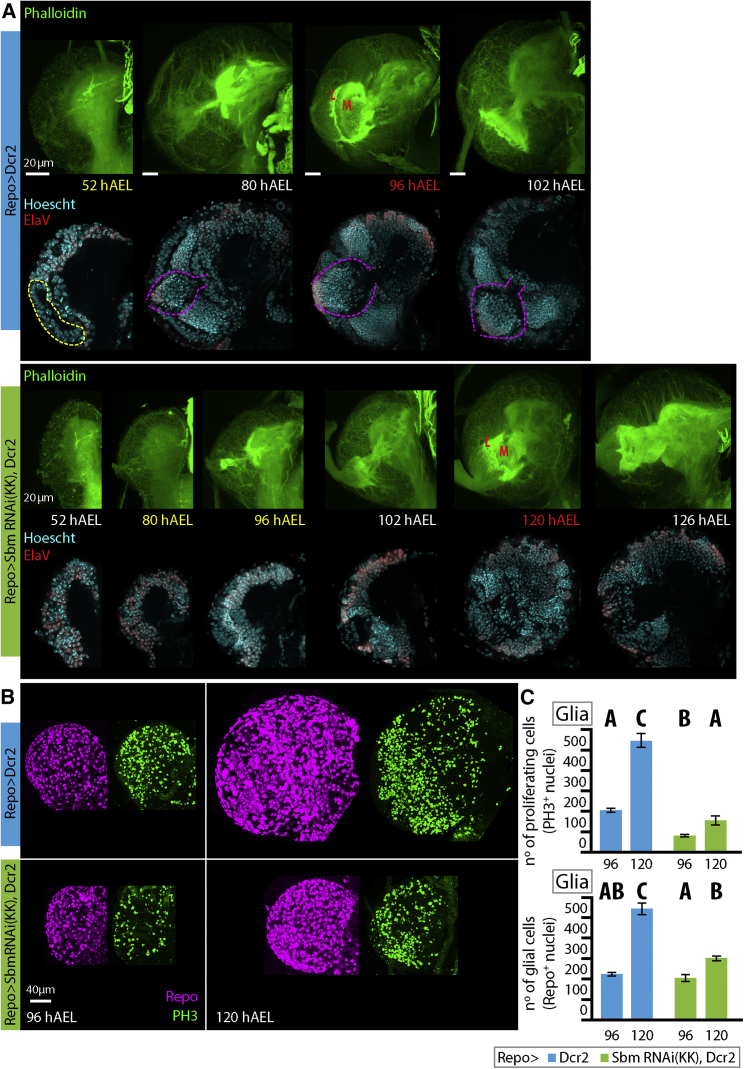
Effects of Sbm Downregulation in Glia on Larval Brain Size, Development, and Brain Cell Proliferation(A) Observation of the formation of the optic lobe and its neuropils by staining brains with phalloidin (green, cell membranes) and Hoescht (blue, nuclei) and neurons (ElaV, red) at different time points through larval development (hAEL, hours after egg laying) shows that Sbm downregulation in glia produces a delay in the development of larval brain structures. In control brains (top two rows), a group of ElaV-negative (red) cells is observed at 52 hAEL (region marked by broken yellow line) in glia Sbm RNAi-treated larvae (bottom two rows); this is not observed earlier than the mid-third-instar larval stage (80–96 hAEL). In control brains, optic lobe formation is already evident by the early third-instar (80 hAEL, broken yellow lines), and the optic lobe (L) and medulla (M) neuropils are already formed in mid-third-instar larvae (96 hAEL). In Sbm RNAi-treated larvae, optic lobe formation seems to occur between 96 and 102 hAEL, and neuropils are seen at 120 hAEL. It is important to note that while structures form, they do not seem to have the regularity observed in controls.(B) Representative pictures showing proliferating cells (PH3, green) and glial cells (Repo, magenta) in the brain of control Repo > Dcr2 (top row) and Repo > SbmRNAi Dcr2 (bottom row) larvae at 96 and 120 hAEL.(C) Quantification of the number of proliferating cells (top) and the number of glial cells (bottom) (two-way ANOVA and Duncan post-test, p < 0.0001, F = 34.33 and F = 37.96; n = 3–6). Points with different letters signify that they are significantly different (p < 0.05); data represent mean ± SEM. hAEL, hours after egg laying.